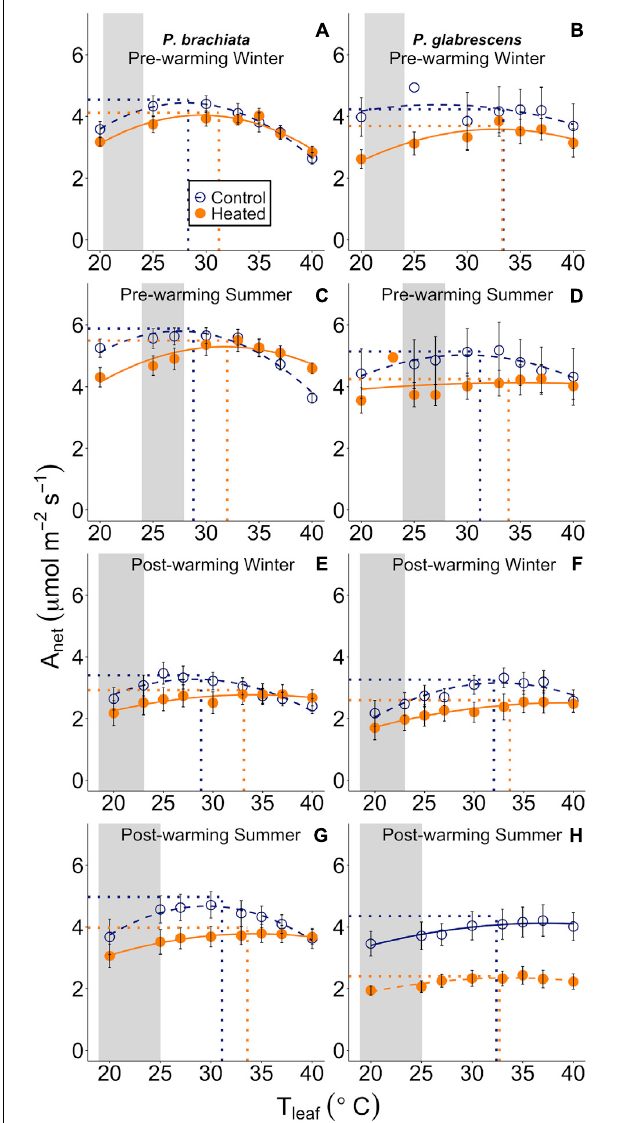
FIGURE 3 | Net photosynthetic ( A net ) response to instantaneous leaf temperatures ( T leaf ). The relationship between net photosynthesis and temperature was plotted separately for each measurement campaign and species: (A) Psychotria brachiata pre-warming winter season, (B) Piper glabrescens pre-warming winter season, (C) P. brachiata pre-warming summer season, (D) P. glabrescens pre-warming summer season, (E) P. brachiata 4 months post-warming winter season, (F) P. glabrescens 4 months post-warming winter season, (G) P. brachiata 8 months post-warming summer season, (H) P. glabrescens 8 months post-warming summer season. Control plot (dark blue open circles) and heated plot (orange closed circles) are means ± se at each leaf temperature. Lines are fit to each temperature response using the June et al. (2004) method (Eq. 1) for control (dark blue; dashed) and heated (orange; solid) plots separately. Dotted vertical lines represent the optimum temperature for photosynthesis. Dotted horizontal lines represent the rate of photosynthesis at the optimum temperature for plants in control (dark blue) and heated (orange) plots separately. Gray boxes represent the range of the average minimum and maximum daily vegetation temperature observed for the control plots. Average minimum and maximum temperatures are calculated for each measurement campaign